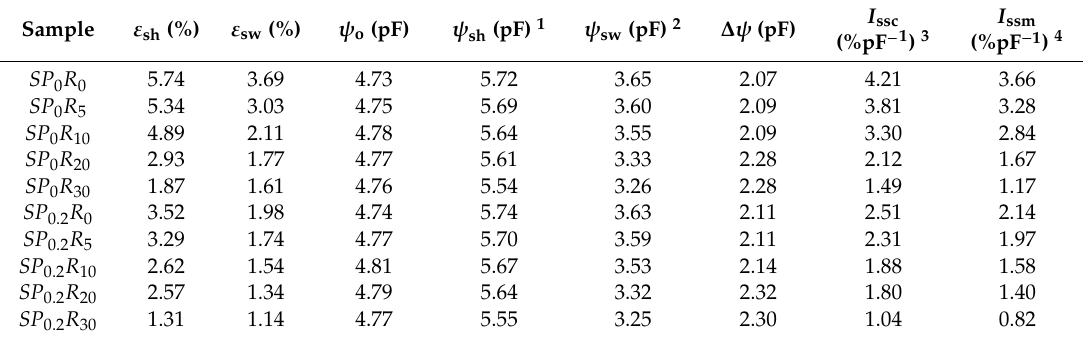
Table 9. Summary of the soil reactivity features for the natural soil and various GR-blended samples— SP x R y where x = {0, 0.2}, and y = {0, 5, 10, 20, 30}.